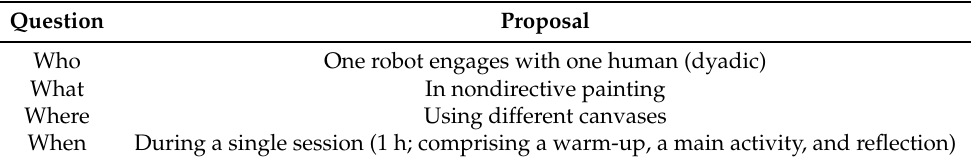
Table 1. Proposal for a basic starting scenario for art therapy